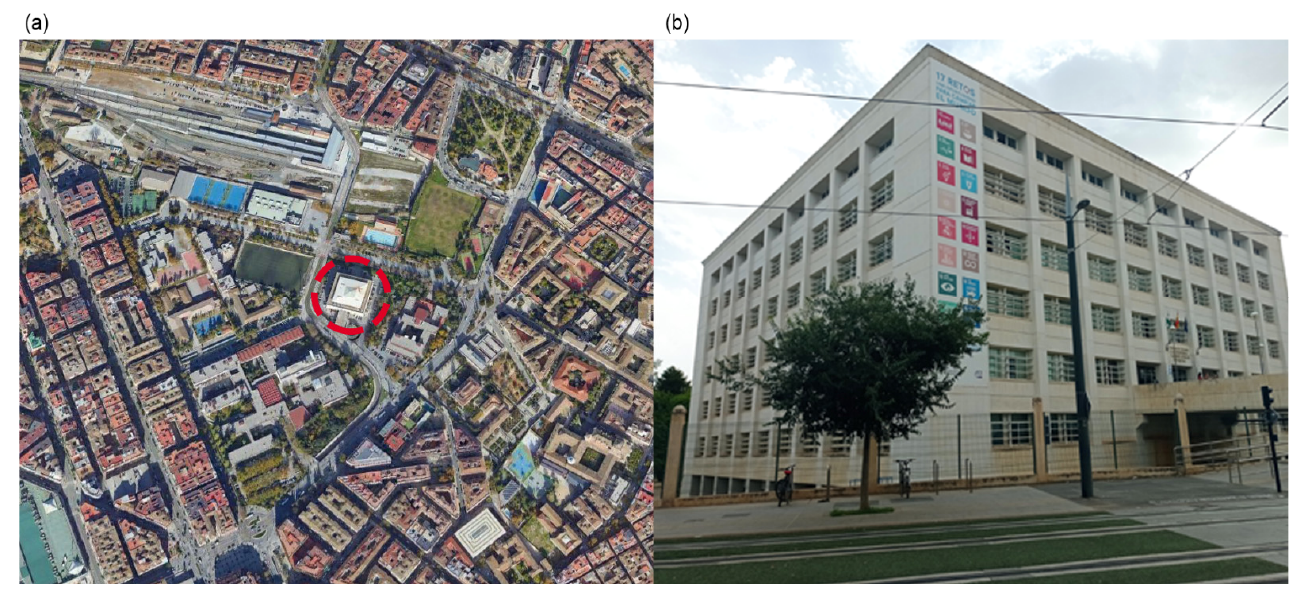
Figure A2. Polytechnic building of University of Granada: ( a ) location, ( b ) façade. Red dotted line indicates the location of the polytechnic building. Table A1. Characteristics of the sensors used to measure the indoor environmental parameters.